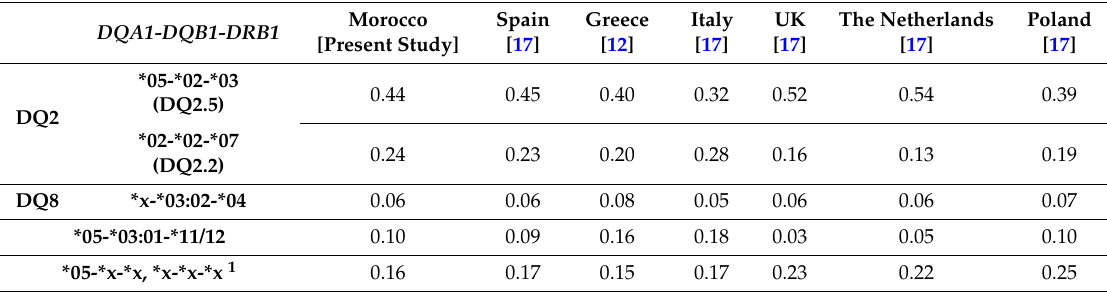
Table 3. Frequency distribution of HLA-DQA1-DQB1-DRB1 haplotypes in celiac disease (CD) in Moroccans and in European